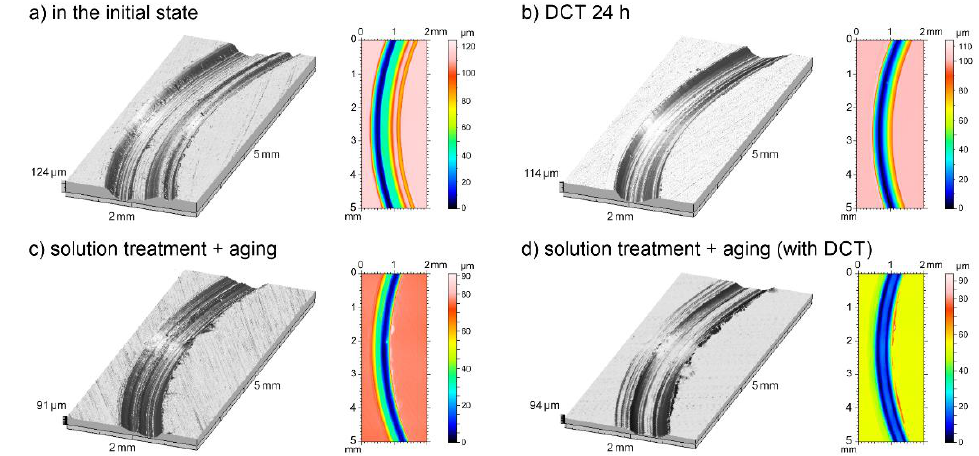
Figure 12. Isometric (3D) and color map (2D) images of wear tracks of the Mg-Y-Nd alloy in initial state ( a ) and after deep cryogenic treatment ( b ), solution treatment + aging ( c ), solution treatment + aging + DCT ( d ).